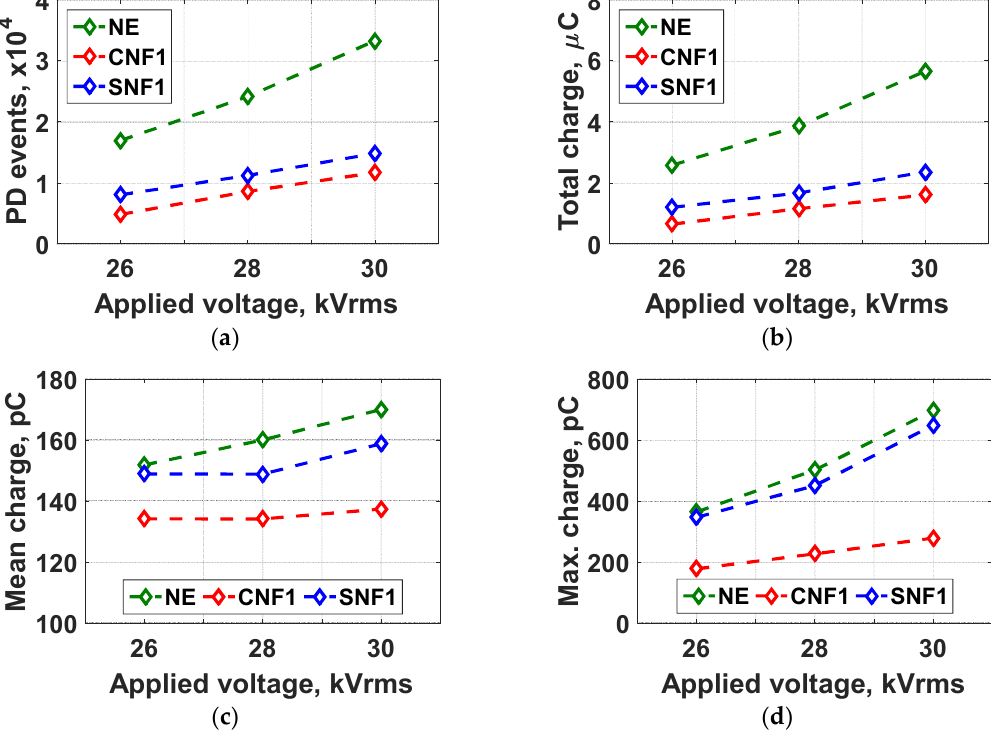
Figure 7. PD activities as a function of the applied voltage amplitudes in 1500 cycles; ( a ) PD events, ( b ) total charge, ( c ) mean charge, and ( d ) maximum charge magnitude.